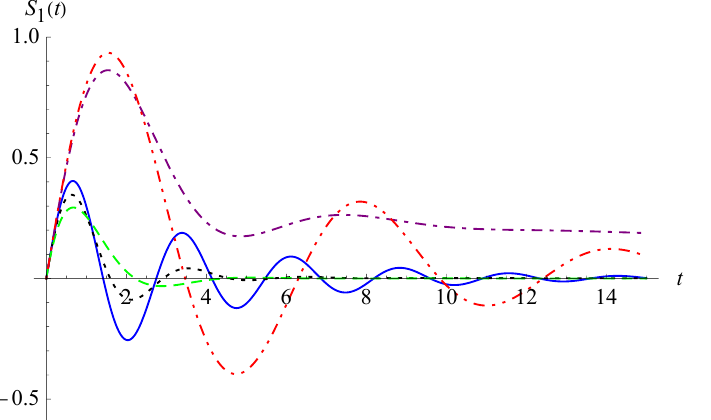
Figure 7. Response S 0 ( t ) for α = 0.3 (solid line), α = 0.65 (dot line), α = 1 (dash line), α = 1.35 (dot–dash line), α = 1.7 (dot–dot–dash line).